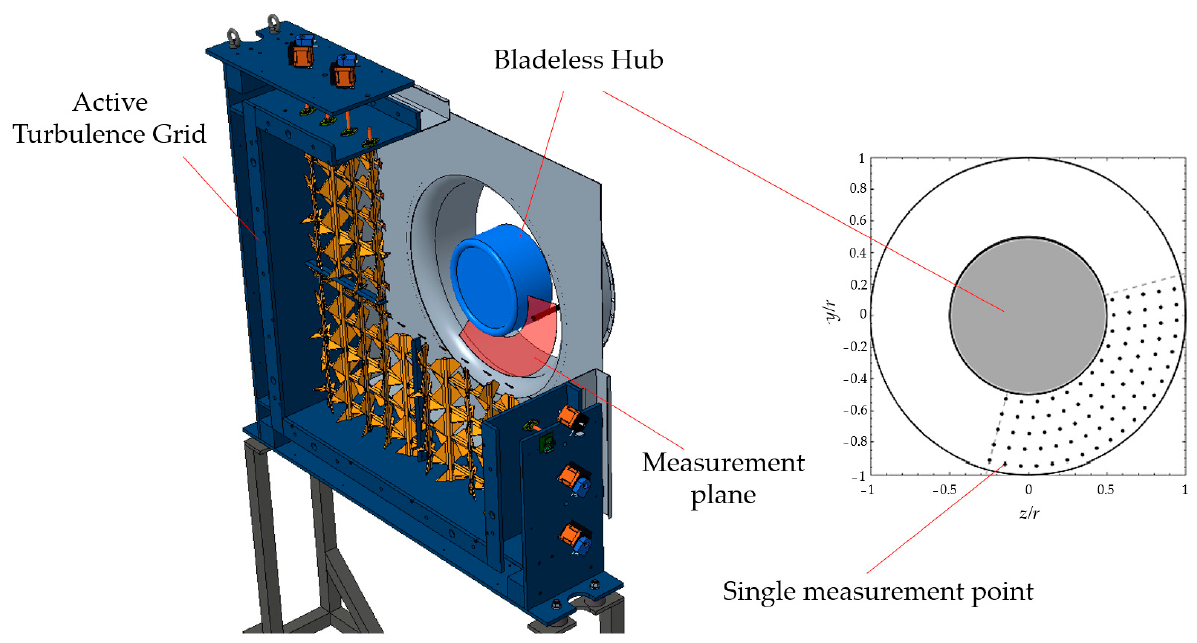
Figure 3. Sectional view of the active turbulence grid with bladeless hub and measuring plane for the hot-wire measurements.